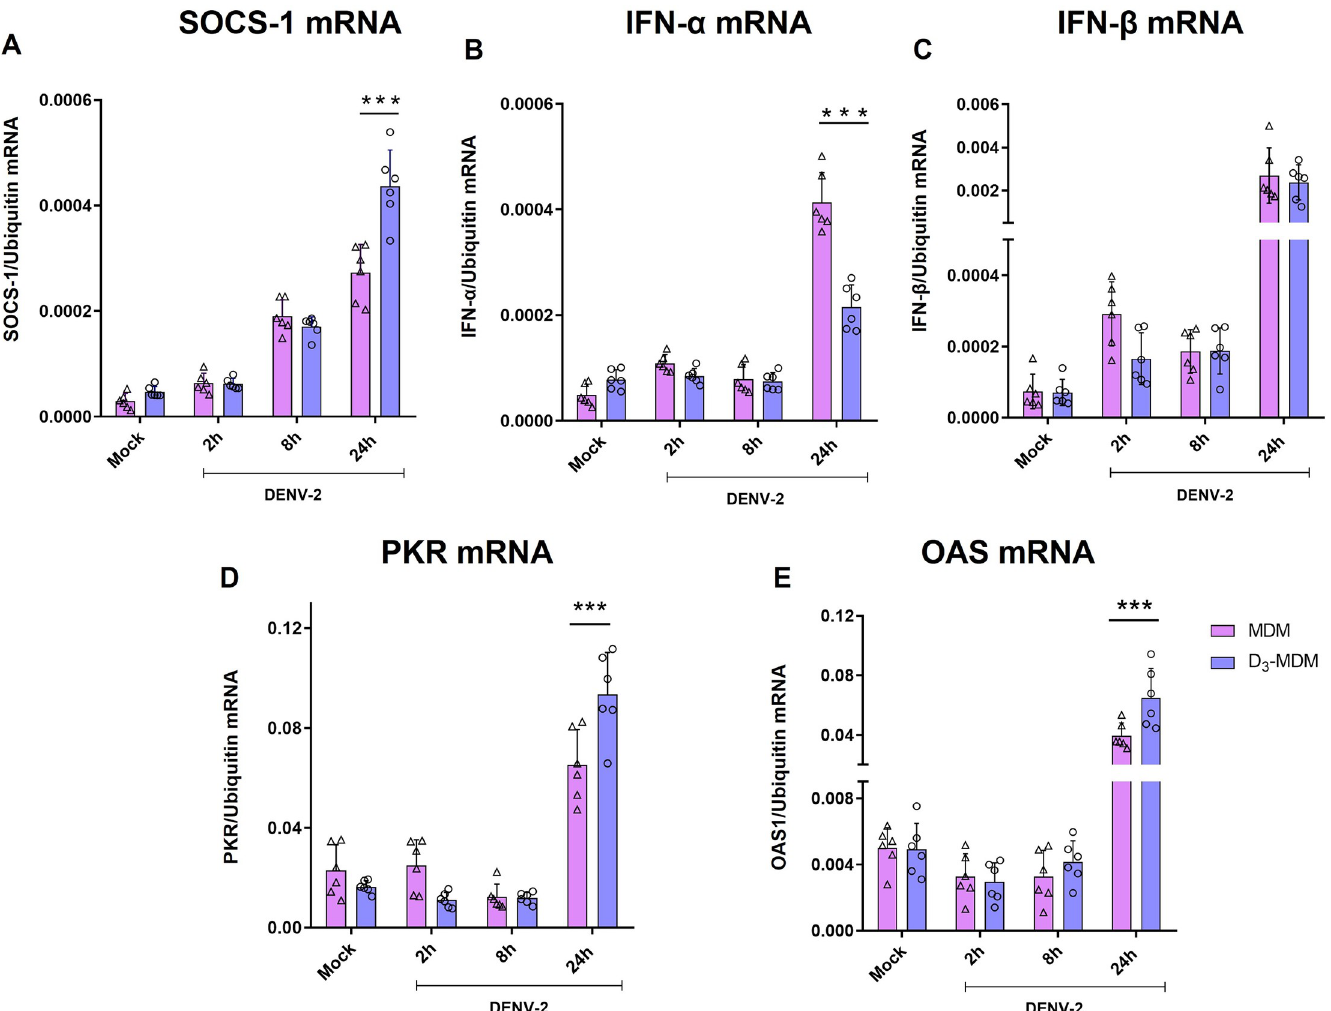
Fig 5. VitD3 upregulates the expression of SOCS-1 and ISGs in D 3 -MDMs. The MDMs were differentiated in the presence of VitD3 (0.1 nM) for 6 days (D 3 -MDMs) and then infected with DENV-2 for 2, 8, or 24 h. Expression of SOCS-1 (A), IFN α (B), IFN β (C), PKR (D), and OAS1 (E) were measured by qPCR in MDMs and D 3 - MDMs using the gene encoding ubiquitin as a housekeeper gene. Data are expressed as fold change relative to mock-treated MDMs and D 3 -MDMs from each time point. Six different donors were analyzed. Differences were obtained with a two-way ANOVA with a Bonferroni post-hoc test and a 95% confidence interval ( ��� p < 0.001, �� p <